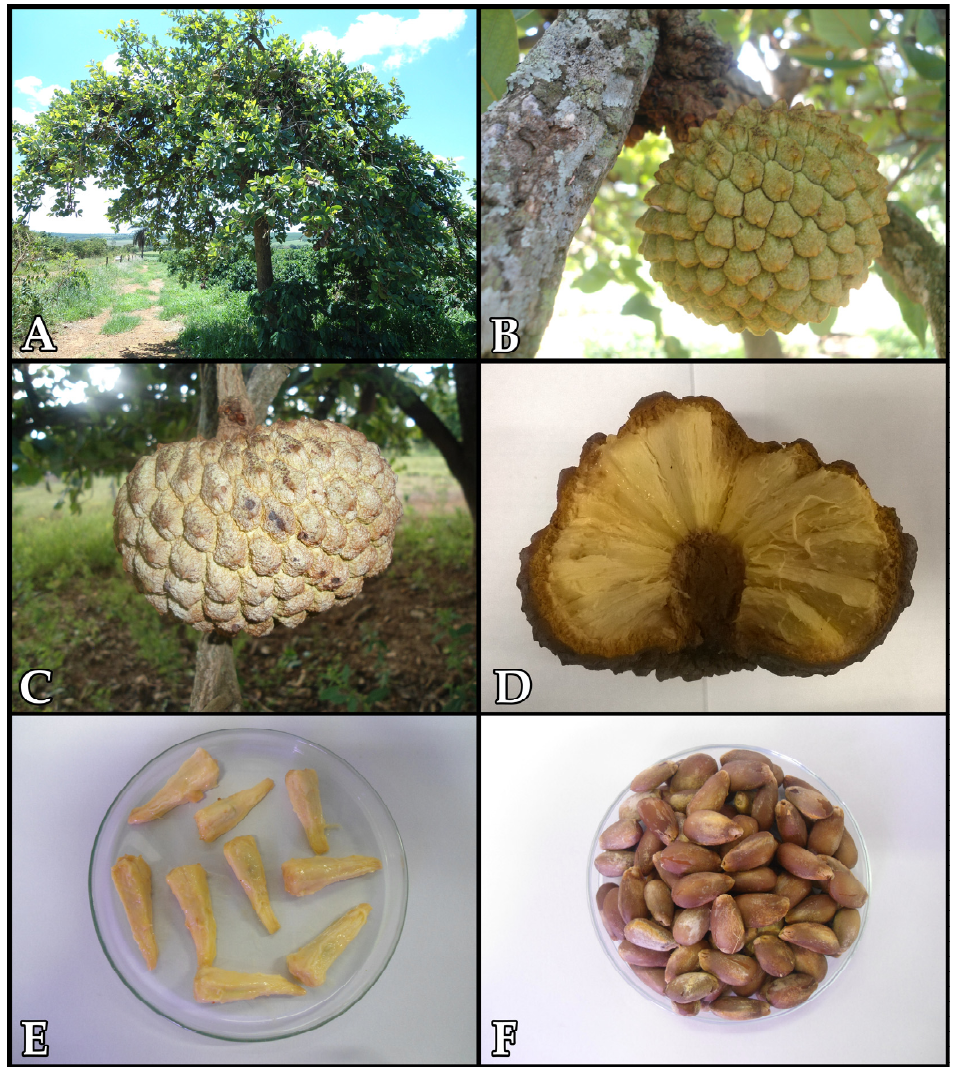
Figure 1. Araticum ( Annona crassiflora Mart.) ( A ) tree, ( B ) unripe fruit, ( C ) ripe fruit, ( D ) fruit cross-section, ( E ) carpels, and ( F ) seeds. Pictures taken by Henrique Silvano Arruda in natural areas of the Cerrado biome located in the city of Carmo do Paranaíba, Minas Gerais, Brazil (altitude of 1061 meters above sea level at a latitude of 19°00 ′ 03 ″ S and longitude of 46°18 ′ 58 ″ W). Araticum fruit parts have been used for centuries by folk medicine to treat di ff erent pathological conditions. The fruit is used by local and traditional medicine as a tonic and